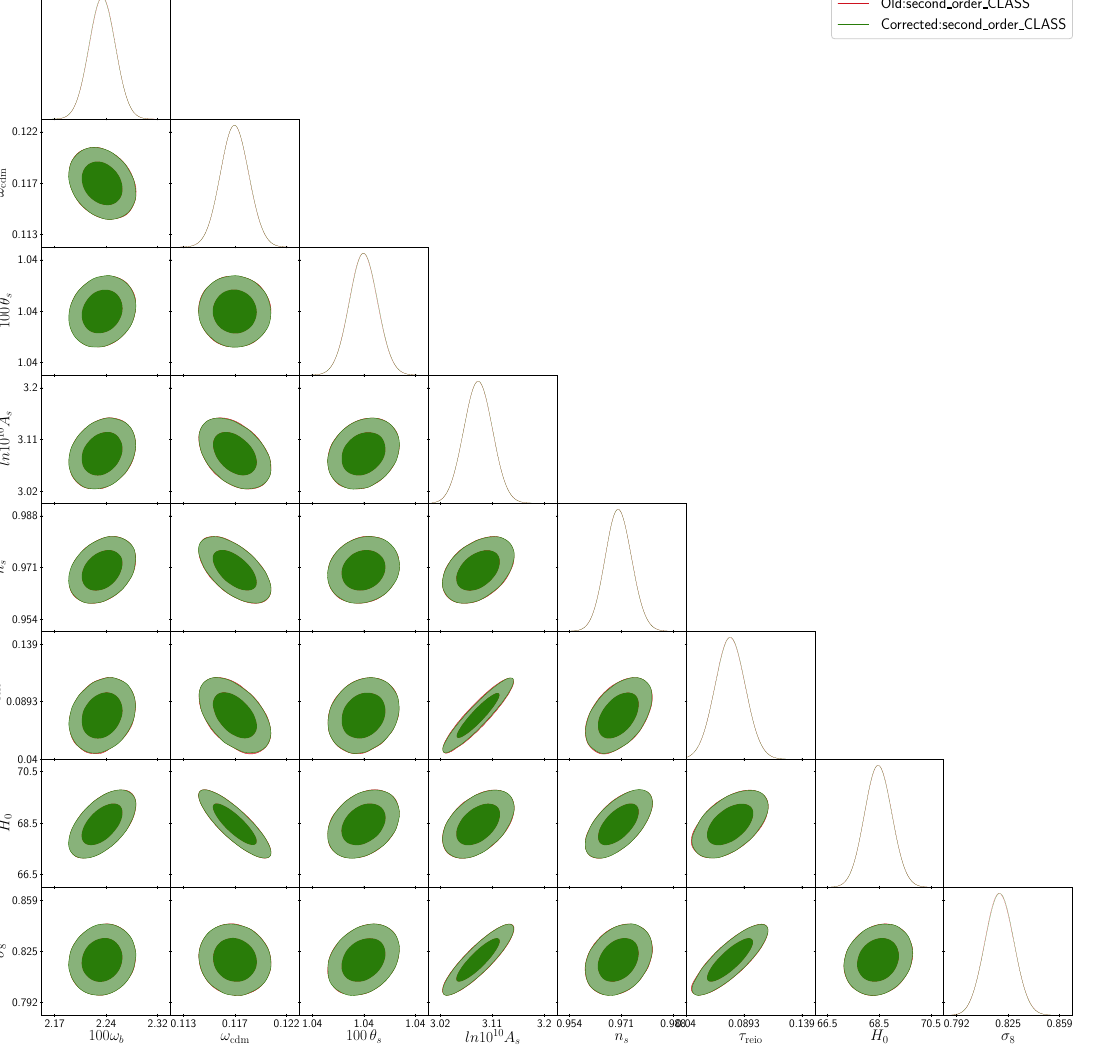
Figure 2. Combined results given by the old, original CLASS code with covariance breaking equations of motion for the baryon and the new code with covariant equations of motion for the baryon fluid. The percent level differences shown in Table 1 are invisible in this figure, but will be important for future